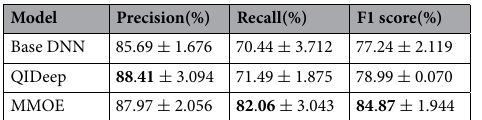
Table 5. Comparison of attack state prediction results. Significant values are in